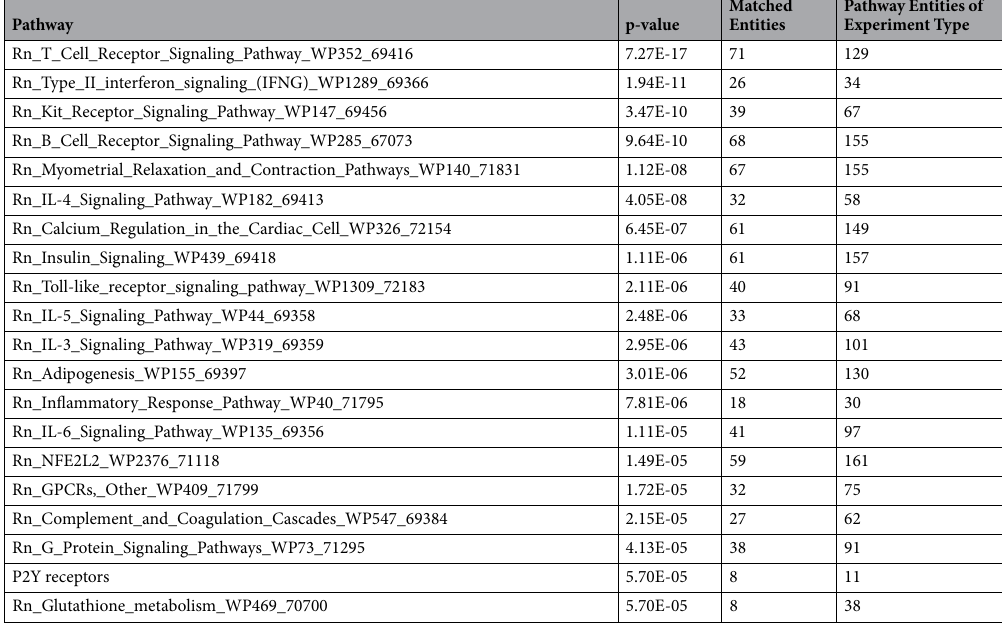
Table 2. Most significantly activated twenty pathways in the MSC population topically applied on TBI brain, using MSC pellet as